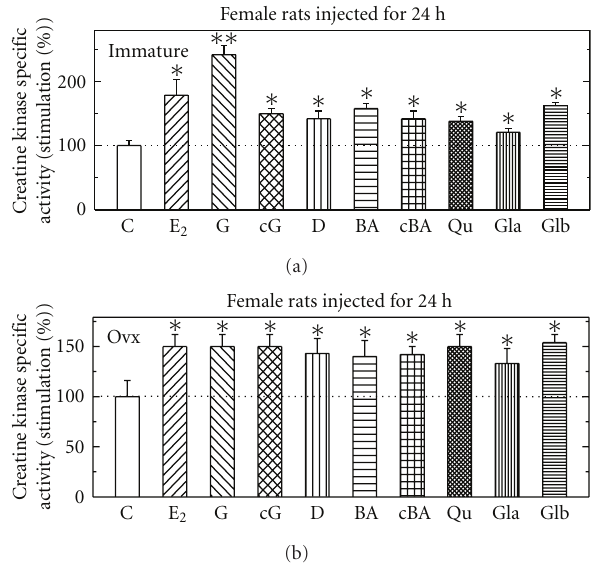
Figure 1: Stimulation of creatine kinase (CK) specific activity by di ff erent estrogenic compounds in pituitary in immature female rats (a) and ovariectomized female rats (b). Rats were treated and assayed for CK activity as described in Section 2. Results are means ± SEM for n = 5–15 rats/group. Experimental means compared to control means: ∗ P < . 05 and ∗∗ P < . 01. Basal activity in pituitary from intact rats was 1 . 12 + 0 . 17 μ mol/min/mg protein and in Ovx rats was 0 . 47 + 0 . 02 μ mol/min/mg